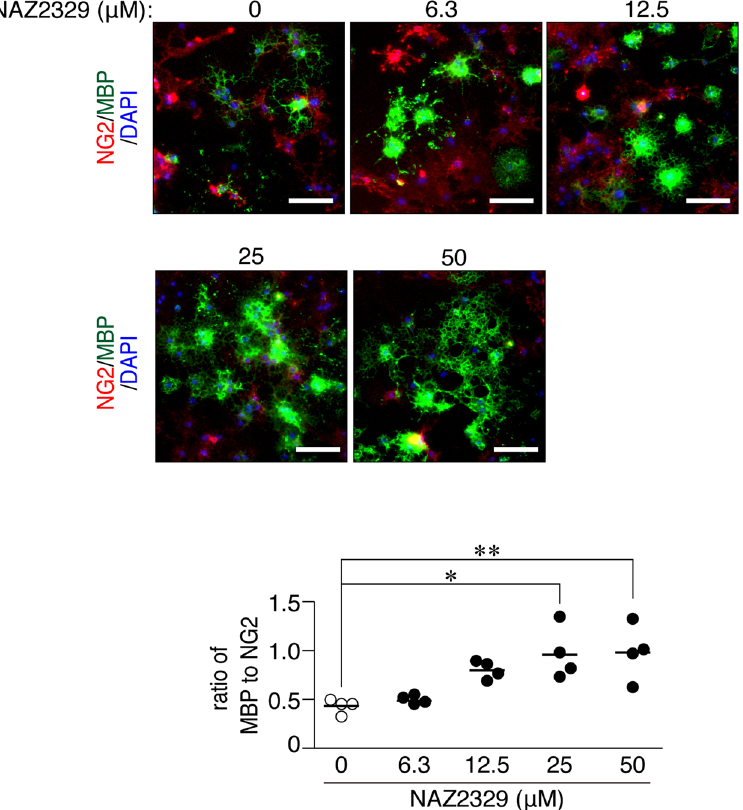
Figure 6. Effects of NAZ2329 treatment on oligodendrocyte differentiation. Mouse oligodendrocyte-lineage OL1 cells were cultured in differentiation media containing the indicated concentrations of NAZ2329. After 10 days, cells were fixed with formalin and stained with anti-NG2 proteoglycan (oligodendrocyte precursor cells, red) and anti-MBP (oligodendrocyte, green) antibodies, in conjunction with the DAPI-labeling of nuclei (blue). Scale bars, 100 µ m. The plot shows the ratio of MBP-positive cells to NG2-positive cells, in which each dot corresponds to an independent cell culture ( n = 4 each). * P < 0.05; ** P < 0.01, significantly different from vehicle-treated cells (one-way ANOVA with Bonferroni post hoc